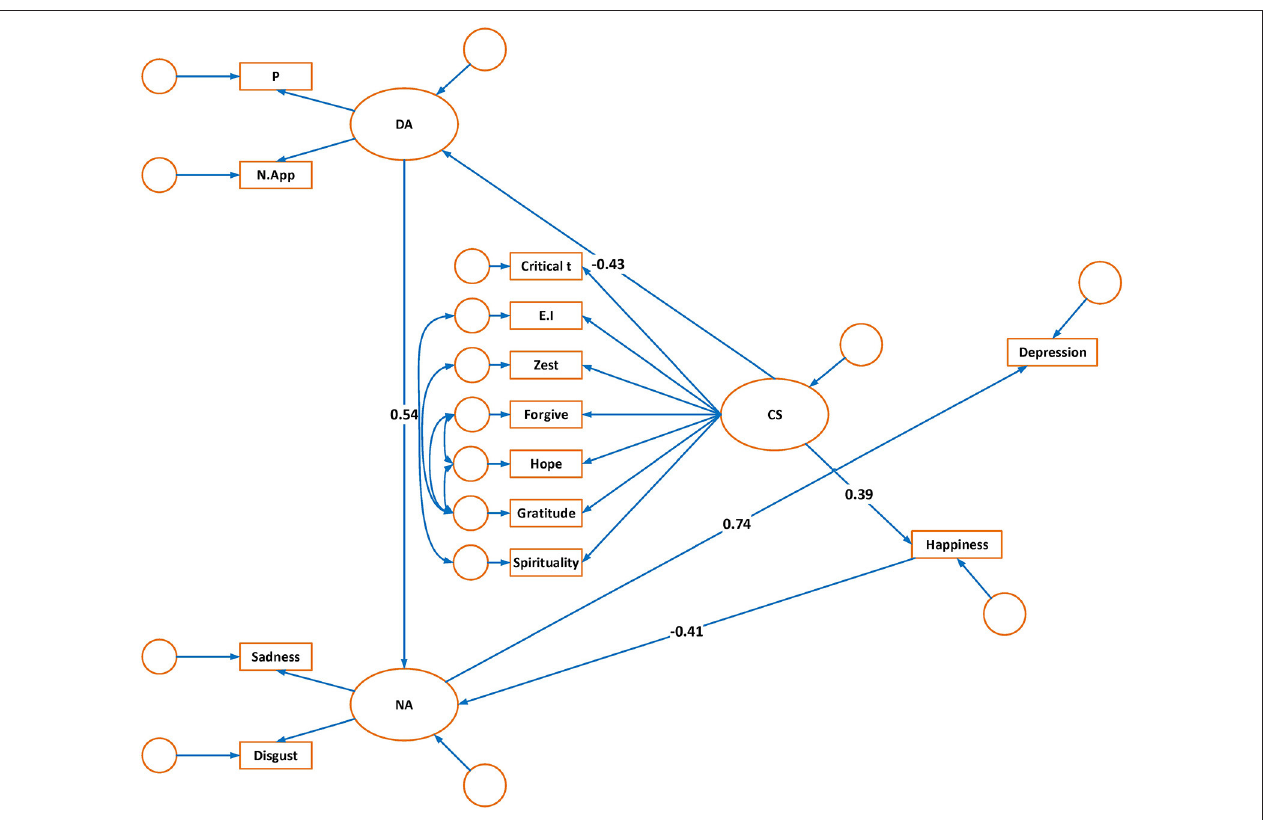
FIGURE 2 | Modified model of depression:structural path coefficients.